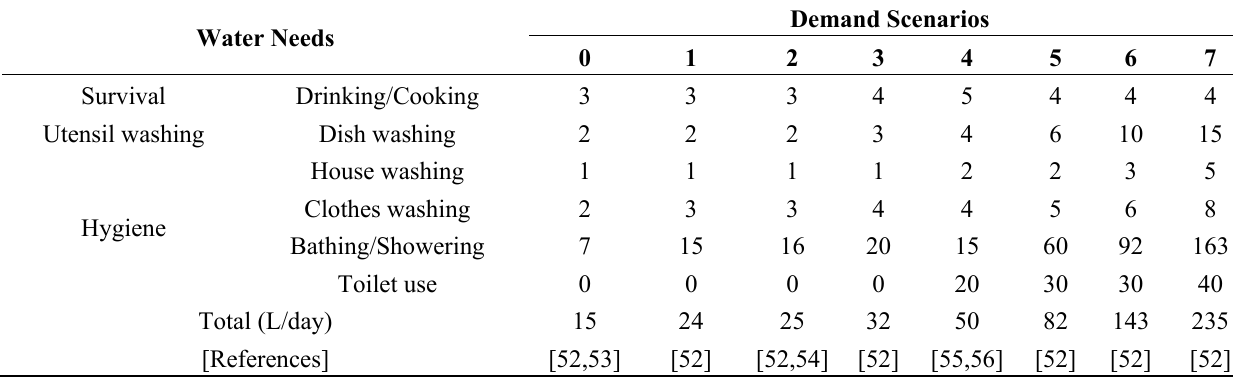
Table 10. Domestic water demand scenarios showing breakdown by water